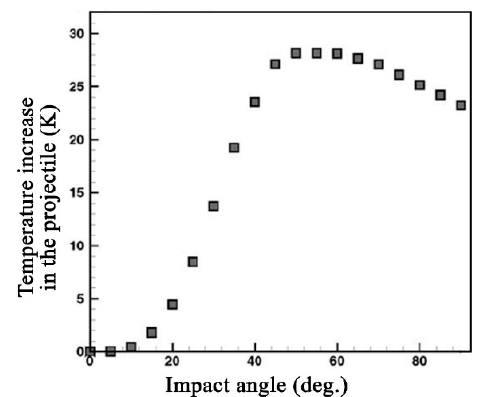
Figure 10. Temperature elevation due to the angle of incidence of the solid particle. Reproduced with permission from [59]. Elsevier, 2002.